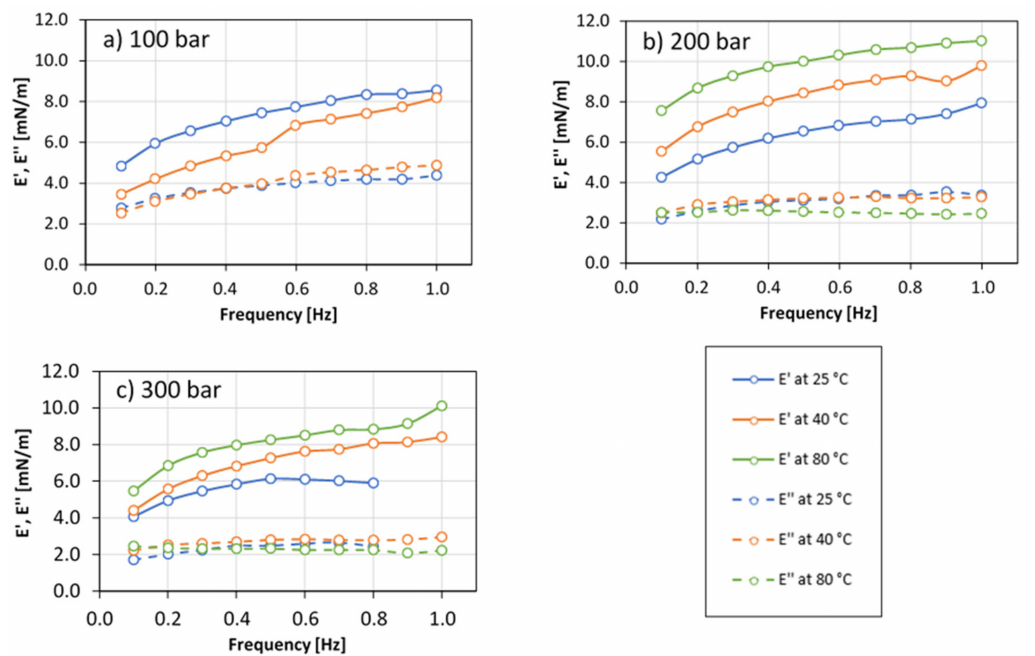
Figure 5. Elastic modulus ( E (cid:48) ) and viscous modulus ( E ”) at temperatures from 25 to 80 ◦ C for pressures of ( a ) 100 bar, ( b ) 200 bar and ( c ) 300